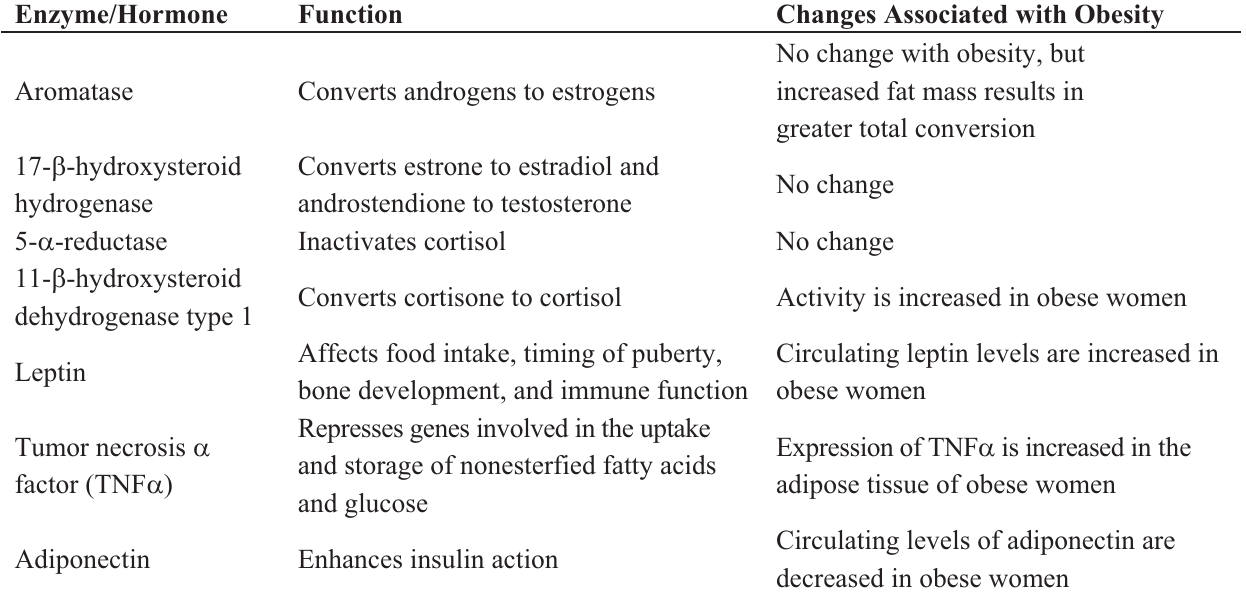
Table 2. Enzymes and hormones produced by adipose tissue